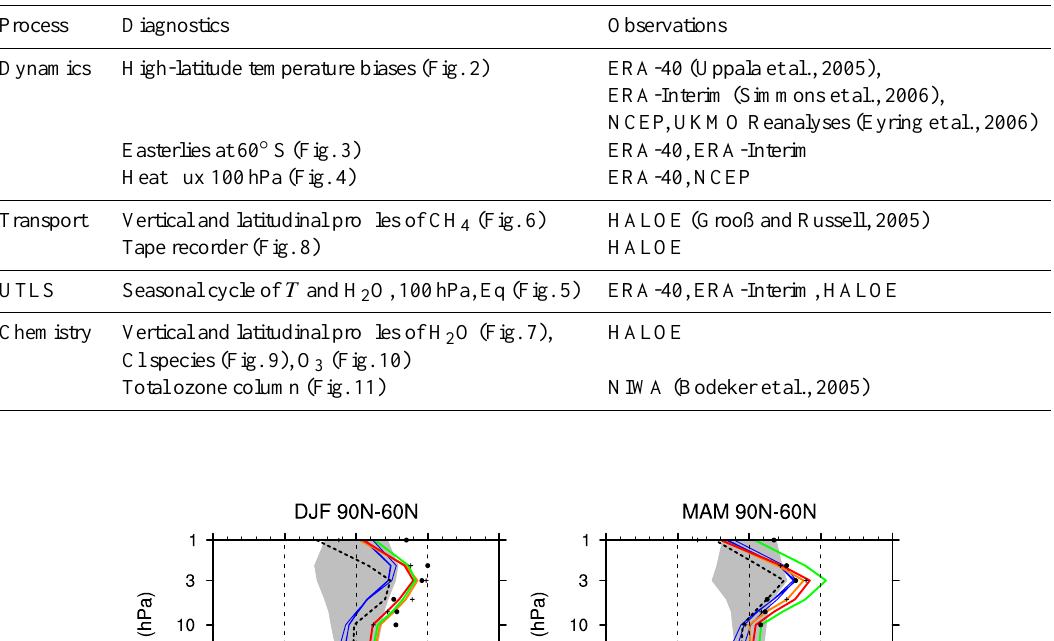
Table 1. Diagnostics and observational data used in this study.